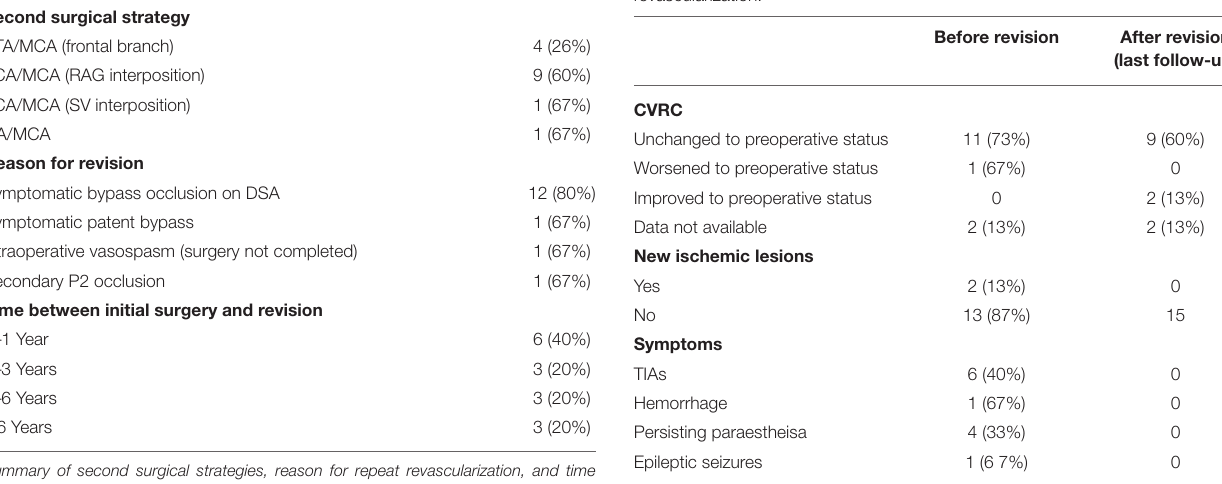
TABLE 4 | Imaging and clinical characteristics before and after repeat revascularization. Before